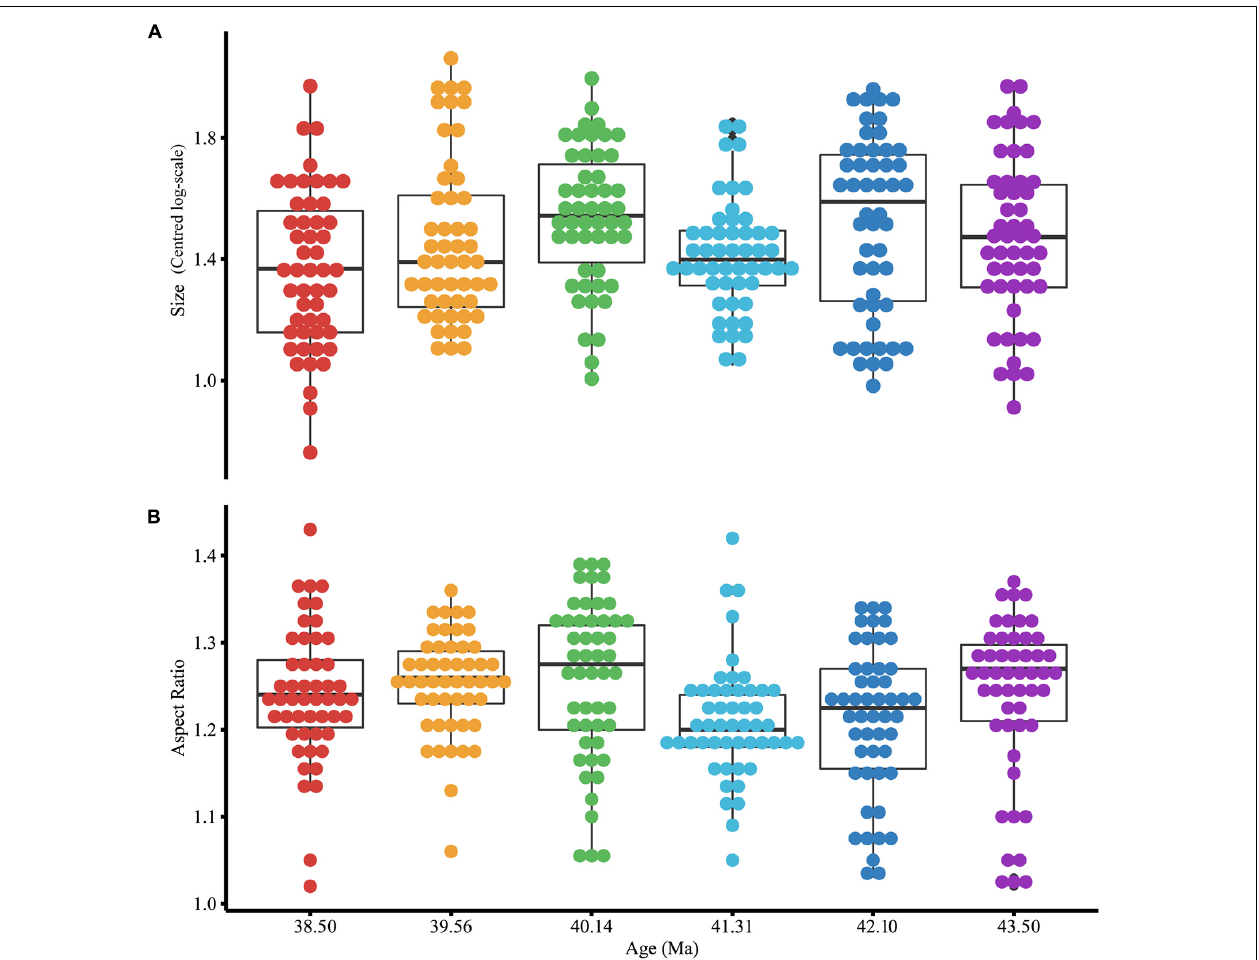
FIGURE 5 | Morphological [test size (A) and test aspect ratio (B) ] variation of all Subbotina measured in this study ( n = 300). Size is on a log scale so has no unit of measure. The box represents the interquartile range whilst the whiskers show 1.5*interquartile range. The black line represents the median. Individual filled symbols represent all individual specimens